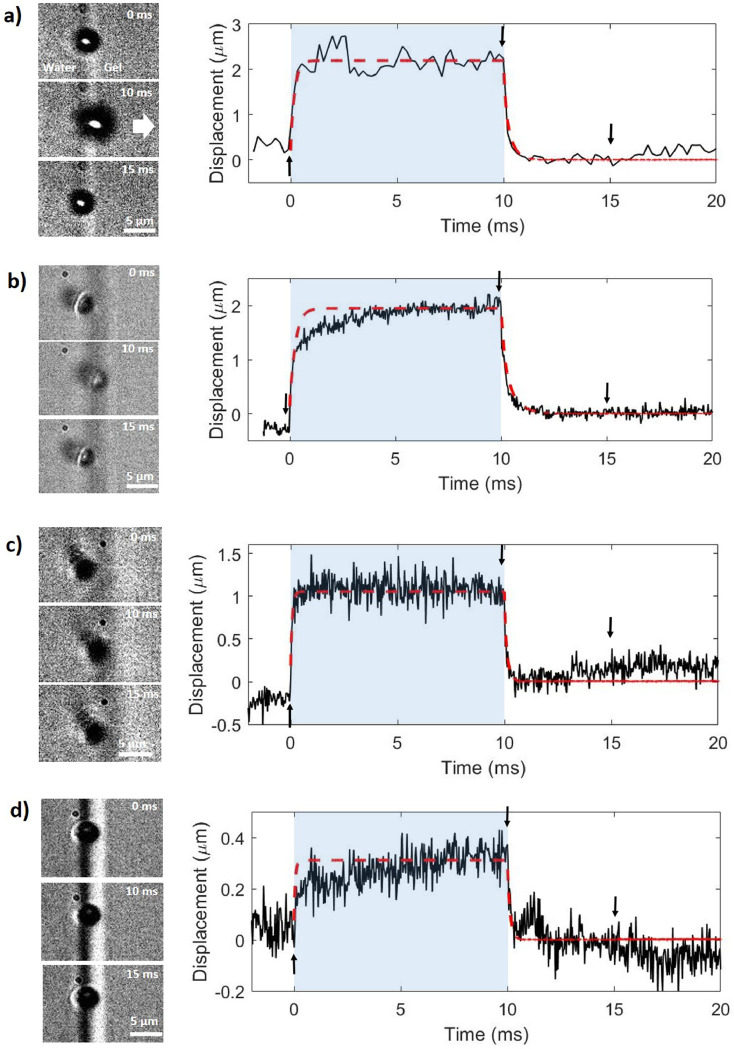
Example indentation curves for four individual bubbles impacting gels with different stiffnesses. Frames from each video are shown on the left, with the x-coordinate of the centre of the bubble shown over time in a plot on the right. Arrows indicate the points at which each still was taken. The duration of the pulse is shaded in blue. Curves fitted to the data based on the mathematical model are represented by dashed lines in red. These curves were used to extract the radiation force on each bubble and the viscosity of the gel. The white arrow indicates the direction of wave propagation (left–right in all images). (a) Example deformation curve for a 2.0-μm radius bubble indenting a gel with a Young's modulus of 2 kPa. Frame rate: 4,858 frames per second (fps). Parameters extracted from the model are radiation force = 19 nN and viscosity = 0.12 Pa·s. Taken from Supplementary Video S1 (online only). (b) Bubble radius = 1.5 μm. Gel Young's modulus = 2 kPa. Frame rate = 31,197 fps. Radiation force = 13 nN, viscosity = 0.18 Pa·s. Taken from Supplementary Video S2. (c) Bubble radius = 1.5 μm. Gel Young's modulus = 4.5 kPa. Frame rate = 31,197 fps. Radiation force =15 nN, viscosity = 0.12 Pa·s. Taken from Supplementary Video S3 (online only). (d) Bubble radius = 1.6 μm. Gel Young's modulus = 8.7 kPa. Frame rate = 31,197 fps. Force = 4.5 nN, viscosity = 0.2 Pa·s. Taken from Supplementary Video S4 (online only).